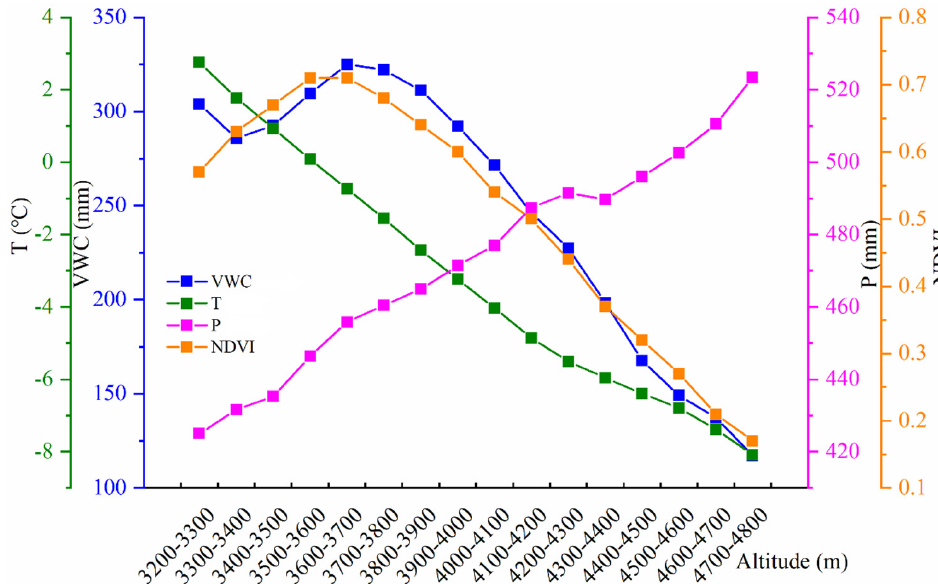
Figure 11. The VWC, annual average temperature, precipitation, and NDVI change along the altitude gradient in the Qinghai Lake Basin from 2000 to 2014.